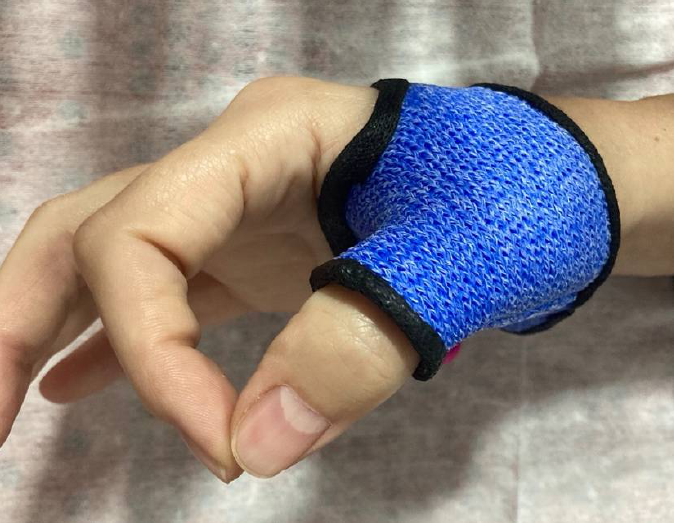
Figure 1. Short thumb orthosis.